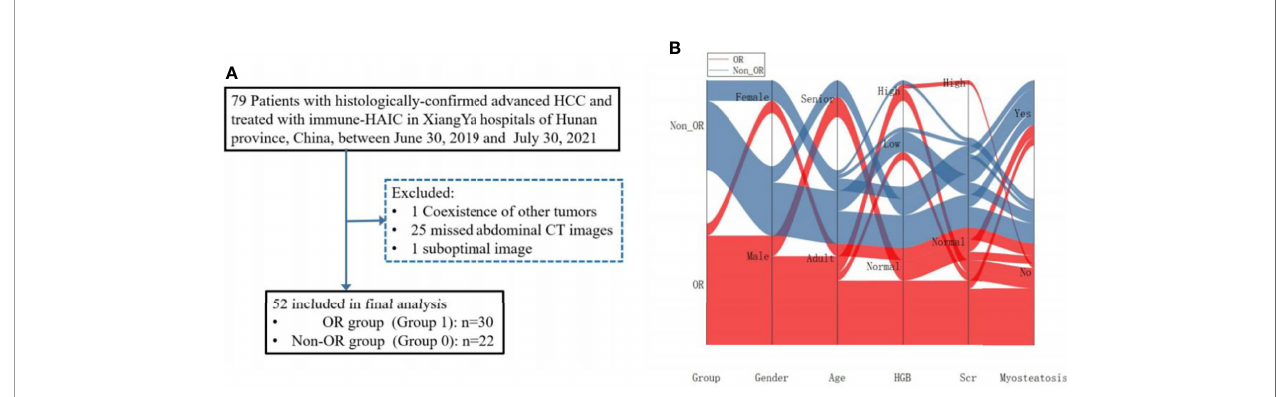
FIGURE 1 | (A) The fl ow-chart illustrating the recruiting procedure for hepatocellular carcinoma (HCC)patients. (B) Sankey diagram exhibiting projectionsof outcomes between the groups, gender, age, HGB, Scr,as wellas